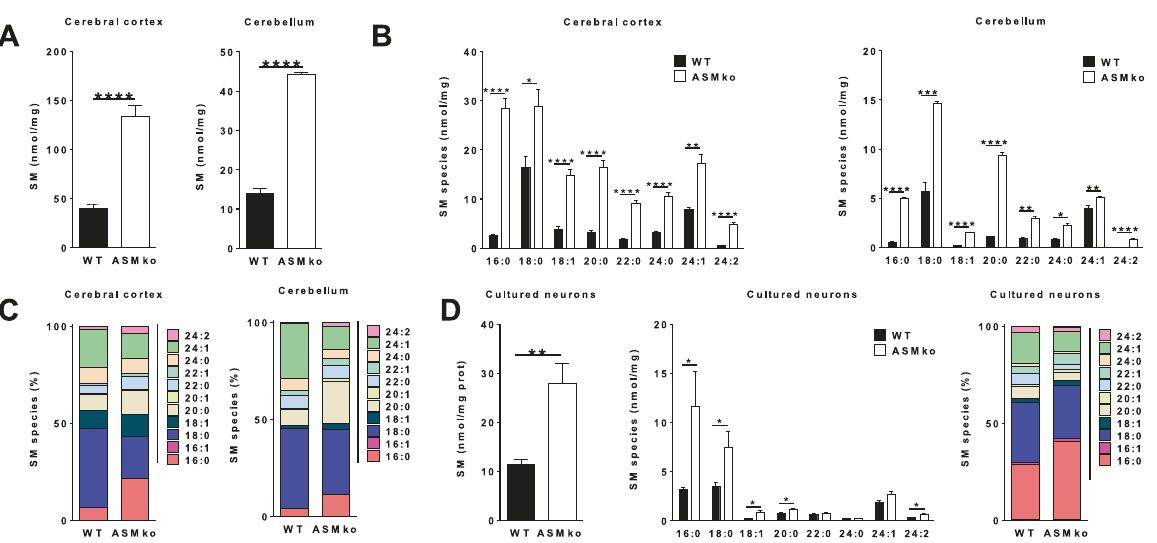
Fig. 1 Variable relative increase of SM species in the ASMko brain and cultured neurons. A Graphs show mean ± SEM of total SM levels expressed as nmol/mg protein in extracts from the cerebral cortex and cerebellum of wt and ASMko mice at 4.5 months of age ( n = 5; **** p < 0.0001). B Graphs show mean ± SEM levels of the indicated SM species expressed as nmol/mg protein in extracts from the cerebral cortex and cerebellum of wt and ASMko mice at 4.5 months of age ( n = 5; * p < 0.05; ** p < 0.01; *** p < 0.001; **** p < 0.0001). C Bars show mean percentages of the indicated SM species with respect to total SM in extracts from the cerebral cortex and cerebellum of wt and ASMko mice at 4.5 months of age ( n = 5). D Graphs show mean ± SEM levels of total SM or SM species expressed as nmol/mg protein (left and middle panels) or mean percentages (right panel) of SM species with respect to total SM in extracts from cultured cortical neurons from wt and ASMko mice ( n = 3 independent cultures; ** p <